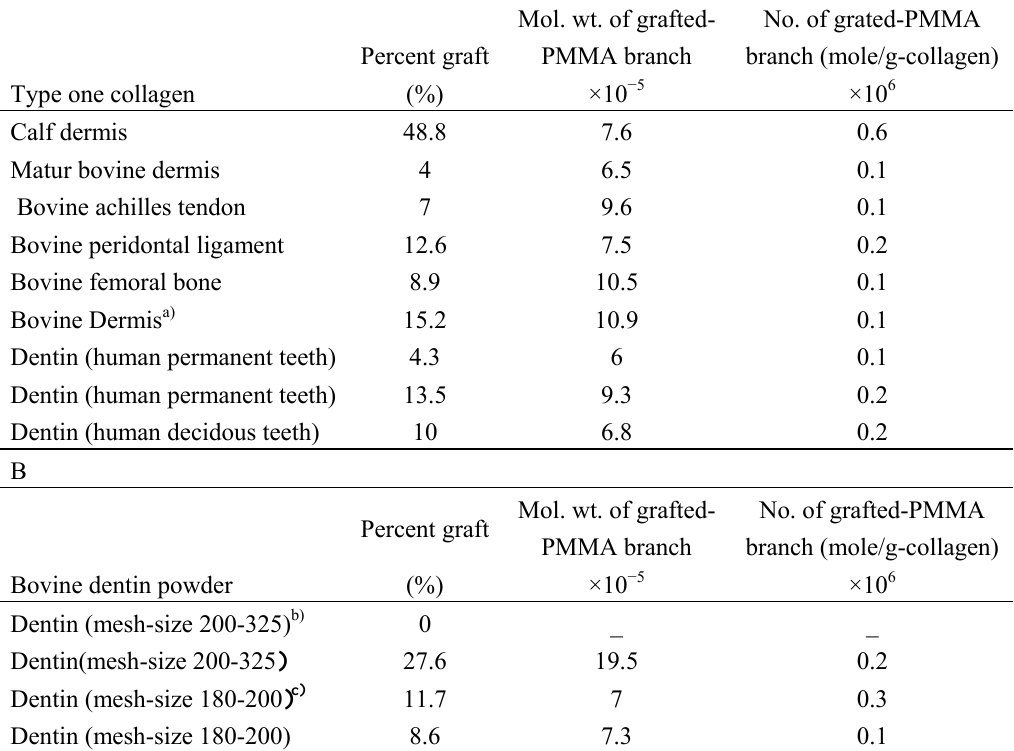
Table 5. Tri- n -butylborane-initiated graft copolymerization of methyl methacrylates with hydrated various collagens (A) and bovine dentin powder